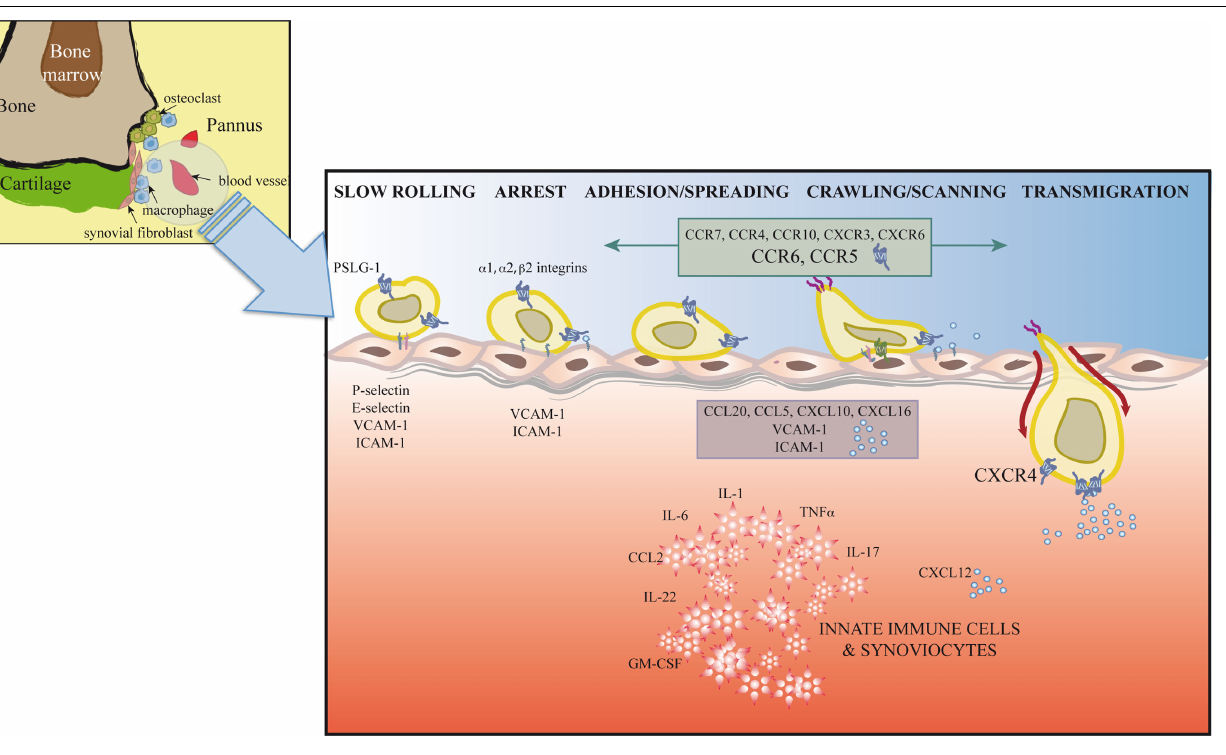
transmigration) and eventually extravasate from blood vessels to the inflamed joint. The figure shows inflammatory cytokines, selectins, integrins, adhesion molecules, chemokines, and chemokine receptors involved in T cell recruitment to and retention in the